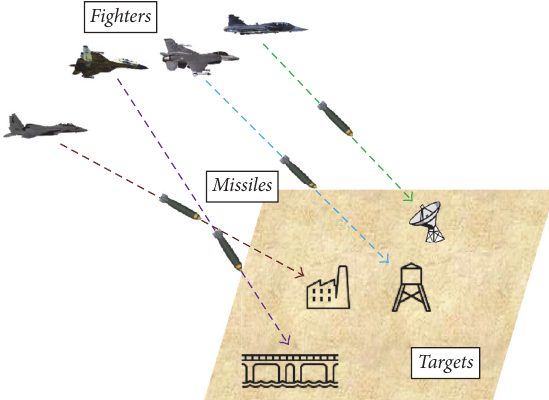
Figure 2: Illustration of the WTA